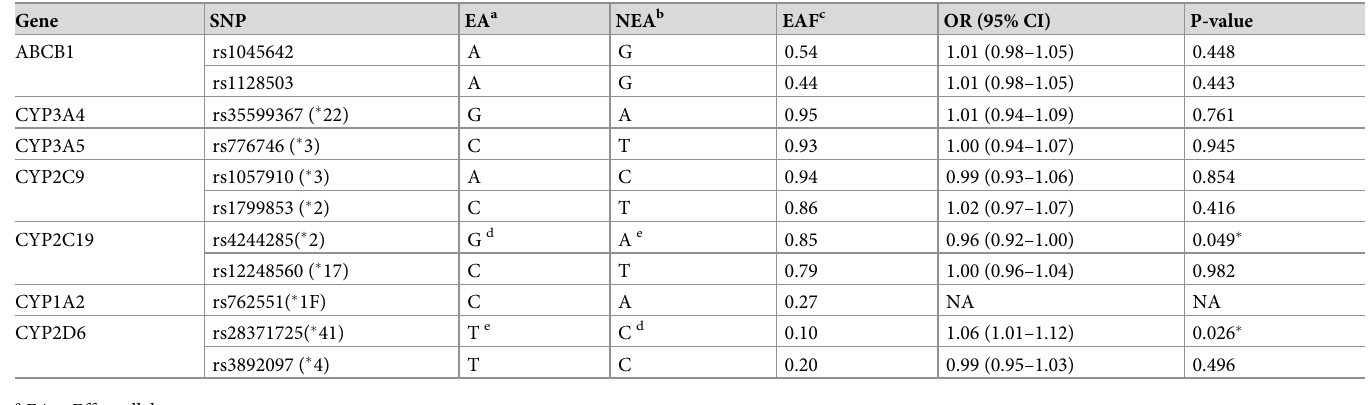
Table 5. Association between candidate SNPs and fall risk in antidepressant users in UKBB. Gene